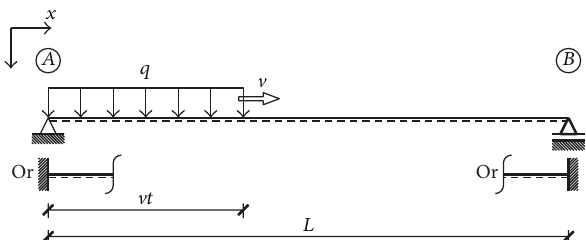
Figure 4: A single-span beam subjected to a moving distributed